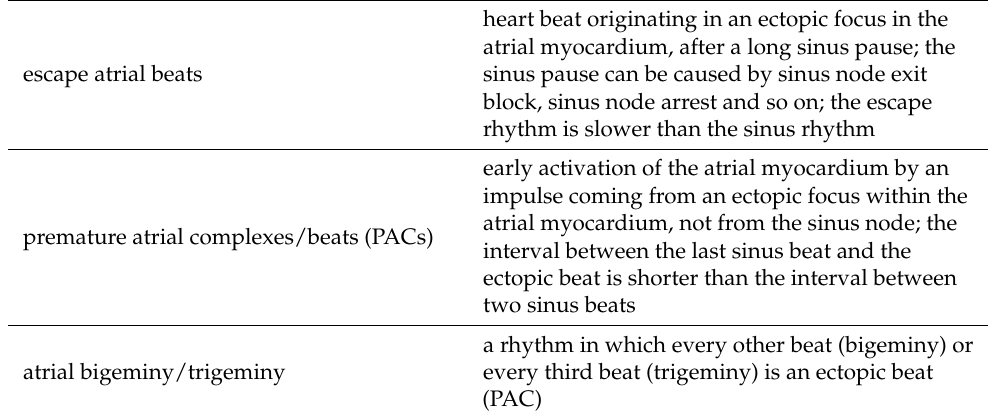
Table A1. Cardiology terminology explained for the fetal medicine specialist [86–88].